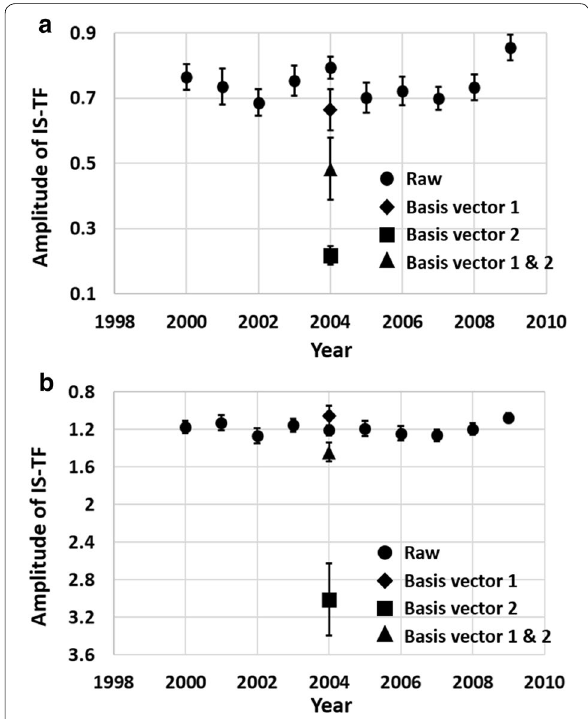
Fig. 9 Year‑to‑year T yy changes between KAK and MMB at a frequency of 9/30,720 Hz. a T xx for KAK/MMB. The circles were derived from the raw geomagnetic data and correspond to the light‑blue dots in Fig. 7c. The diamonds, squares, and triangles in 2004 are derived from the reconstructed data using only Basis vector 1, Basis vector 2, and Basis vectors 1 and 2, respectively. b T xx for MMB/KAK. The circles were derived from raw geomagnetic data, and correspond to the light‑blue dots in Fig. 7d. Note that the directions of the vertical axes in a and b are